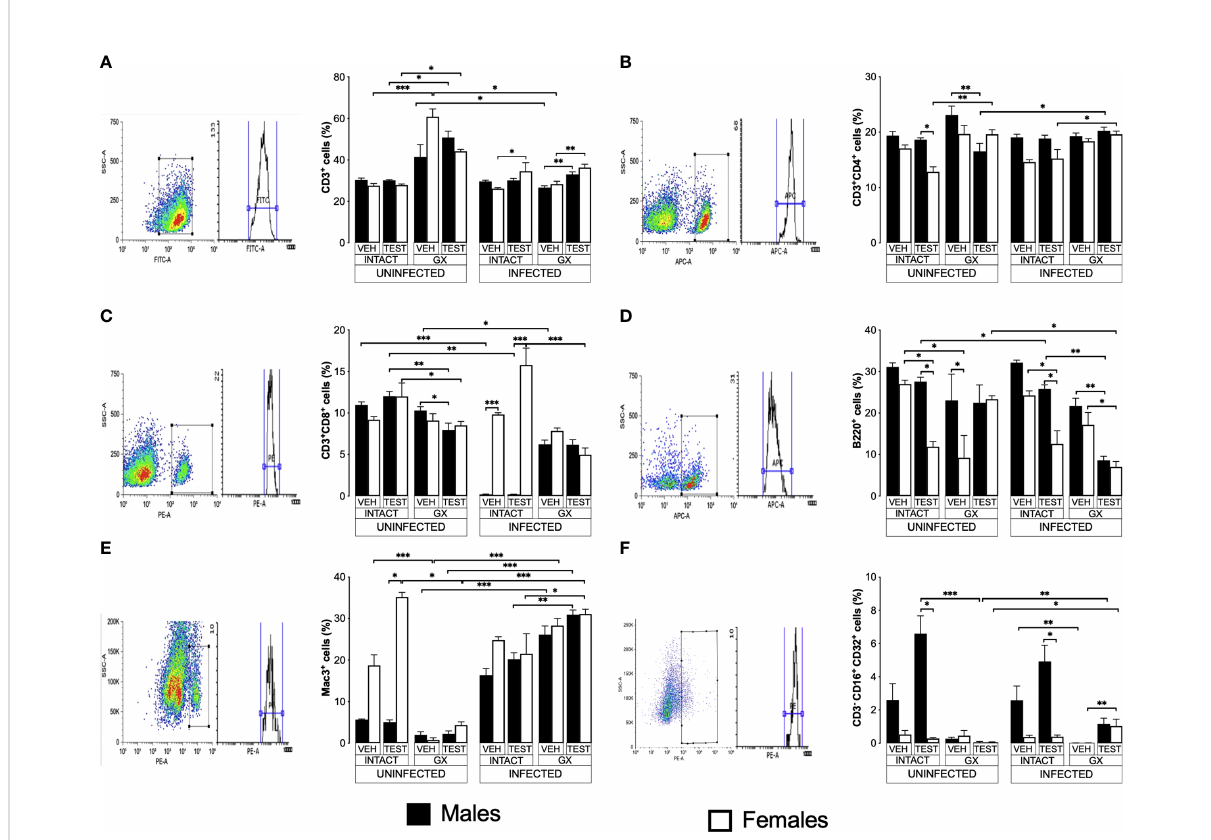
FIGURE 6 Testosterone increased CD3 + , CD8 + , B220 + and Mac3 + populations in females, whereas it increased only the NK in males. We used 8 groups of males and 8 groups offemales, 4 groups of each sex were gonadectomised (GX), and the other 4 groups were left intact; four weeks after surgery, two groups of intact and two GX mice of each sex were administered testosterone for 3 weeks, the other two received vehicle for the same time. Finally, one intact and one GX group, both treated with testosterone of each sex were infected with P. berghei ANKA. The remaining groups were injected with PBS to be used as infection controls. Mice were sacri fi ced on day 8 post infection; spleens were removed and were used to quantify immune response cells by fl ow cytometry using population-speci fi c monoclonal antibodies coupled to different fl uorochromes. The dot plot shows the selection strategy of positive cells and the histogram for each population. In addition, the graph of the mean of the percentage of each cell population ± SEM for each group is presented. (A) shows total CD3 + T lymphocytes; (B) represents CD3 + CD4 + helper T lymphocytes; (C) shows CD3 + CD8 + cytotoxic T lymphocytes; (D) shows B220 + B lymphocytes; (E) represents Mac3 + macrophages, and (F) shows CD3 - CD19 - CD16 + CD32 + (NK cells) of the vehicle-treated (VEH), testosterone-treated (TEST), intact (INTACT), or gonadectomised (GX) groups. Mice infected with P.